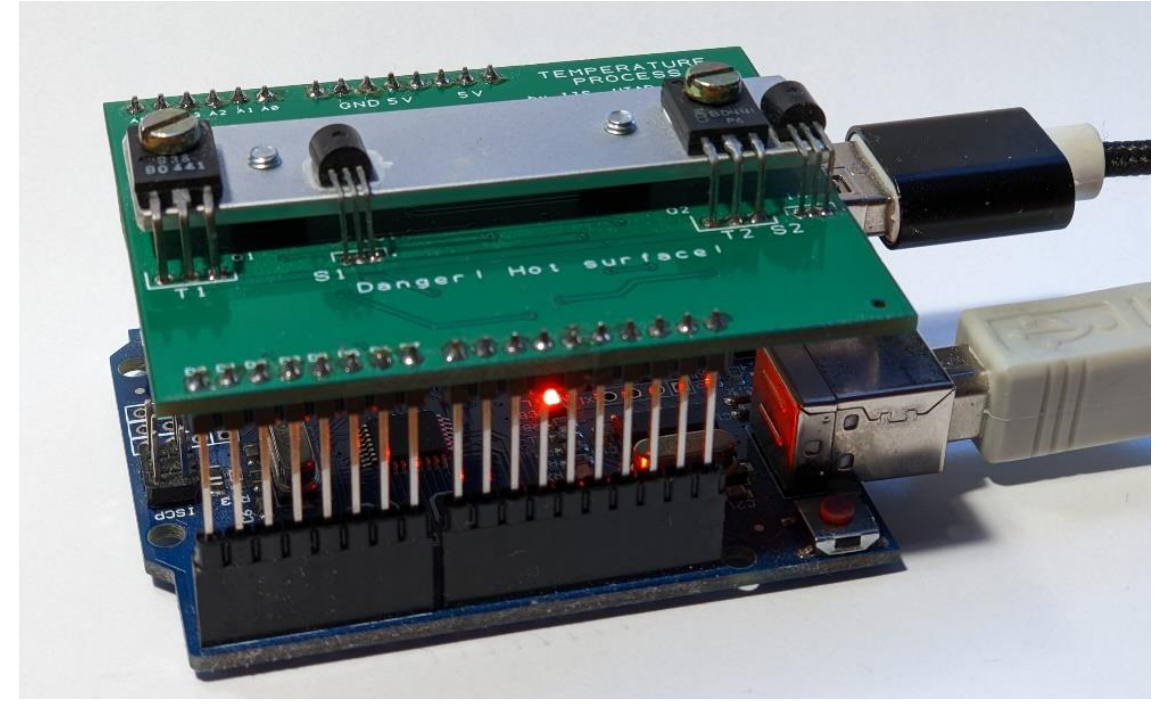
Figure 22. The laboratory thermal process based on the Arduino hardware platform. The electronic scheme of the thermal process, connected to Arduino UNO development board, is shown in Figure 23.